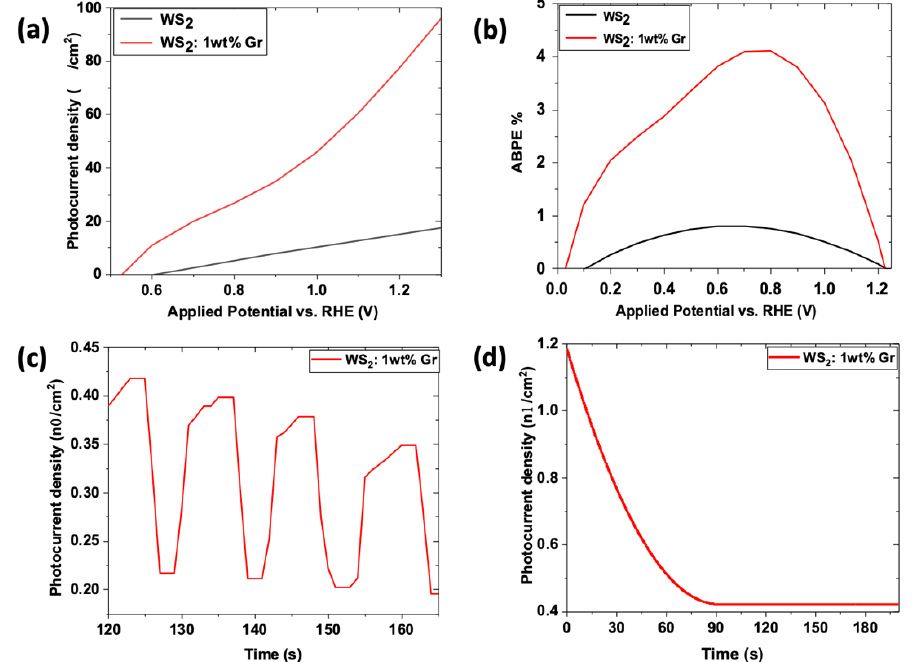
Figure 13. Photoelectrochemical measurements carried out on optimized WS 2 S4 and gra- phene@WS 2 : 1 wt%: ( a ) generated current density as function of applied potential vs. RHE; ( b ) ap- plied bias potential efficiency as function of applied bias with respect to RHE. Chronoamperometry experiment performed on WS 2 : 1 wt% Gr using solar simulator of AM1.5G: ( c ) cyclic and ( d ) steady state tests.